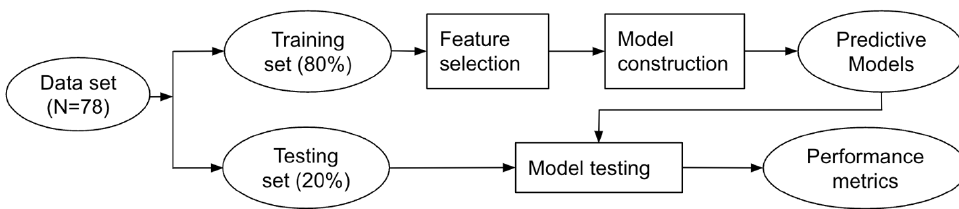
Figure 1. Diagram of the flow chart for data